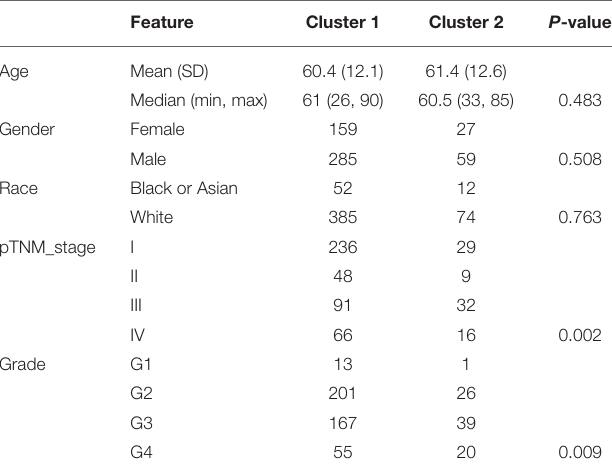
TABLE 1 | Clinical characteristics of two clusters of ccRCC